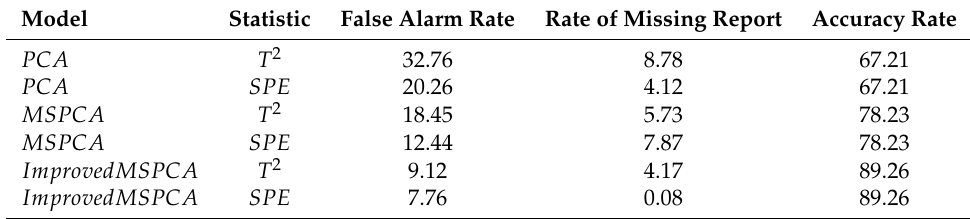
Table 1. Accuracy comparison of traffic detector fault data identification